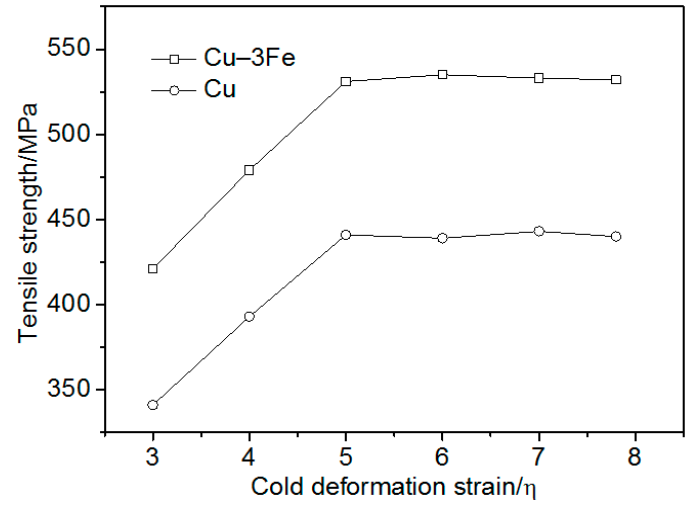
Figure 6. Strength of Cu and Cu–3Fe vs. the cold deformation strain.